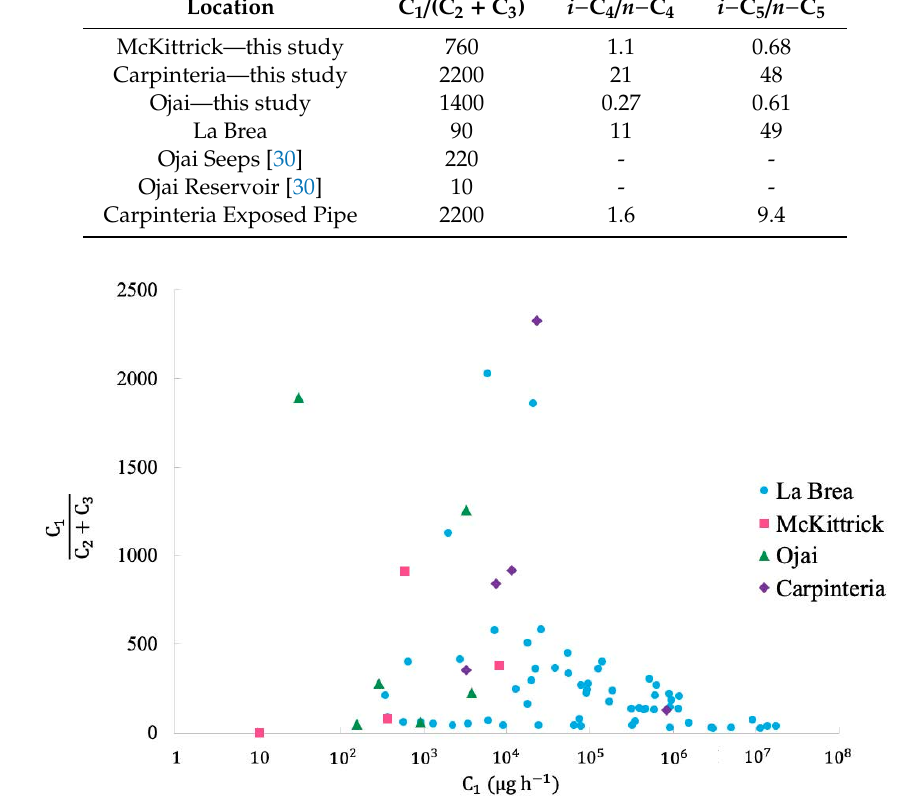
/ (C2 + C3) ratio at the three sites and La Figure 3. Plot of methane flux vs. C1/(C2 + C3) ratio at the three sites and La Brea. Figure 3. Plot of methane flux vs. C1